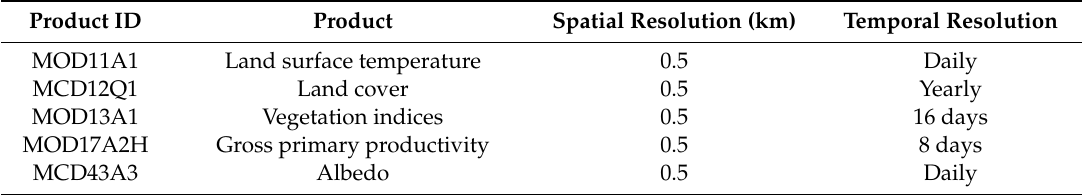
Table 2. Remote sensing data used in this